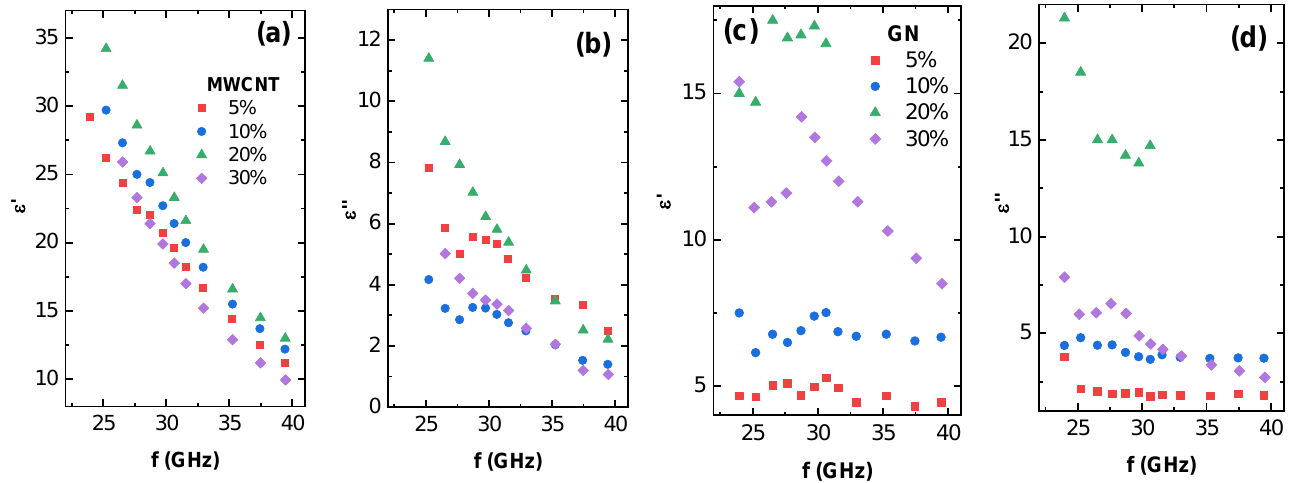
Figure 6. Microwave dielectric spectroscopy ( a ) real part of permittivity for MWCNT composites, ( b ) imaginary part of permittivity for MWCNT composites, ( c ) real part of permittivity for GN composites, and ( d ) imaginary part of permittivity for GN composites.